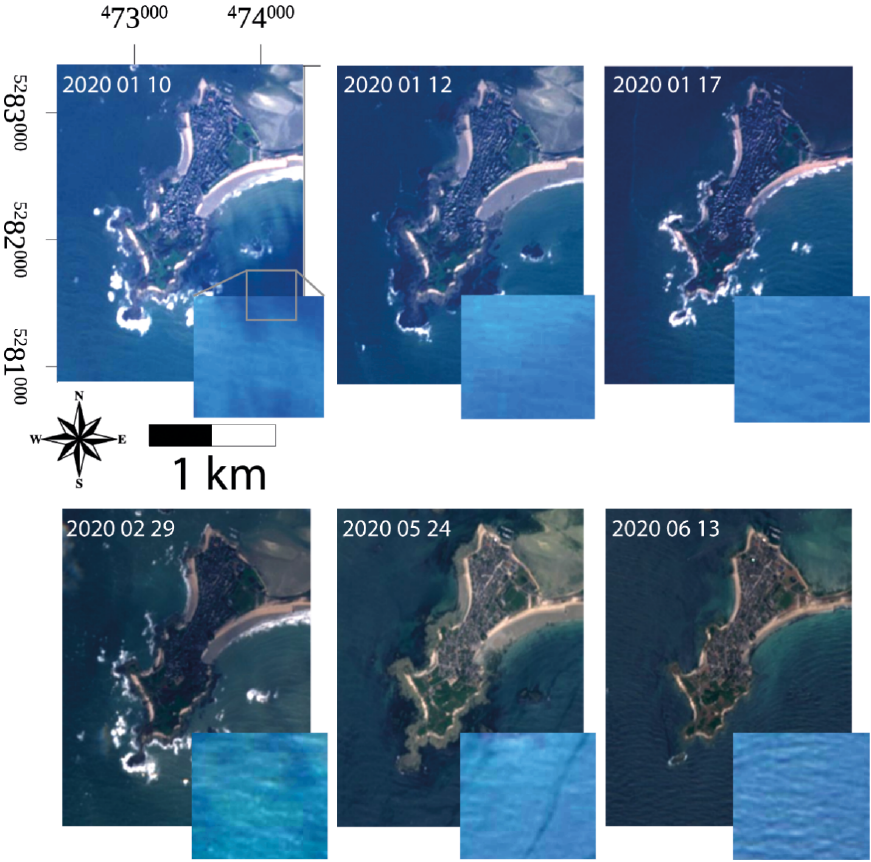
Figure 3. Sentinel 2 dataset centered on the study area and acquisition dates. Color composite with bands 4, 3, 2 displayed as red, blue and green. The grey square presents a closer look image to show how Sentinel 2 recorded waves on different dates. The close-up image colors are enhanced by histogram-stretching for the purpose of visualization. Coordinates are expressed in UTM N30.